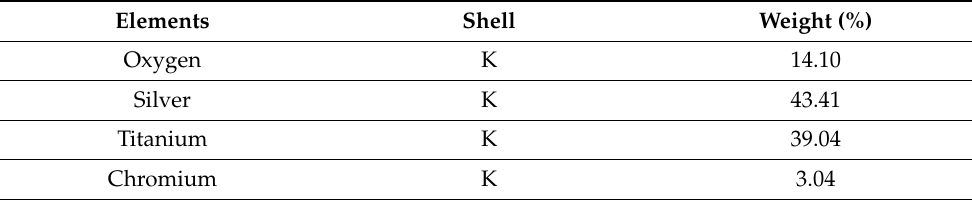
Table 1. Estimated elemental composition of MXene/Ag 2 CrO 4 nanocomposite.